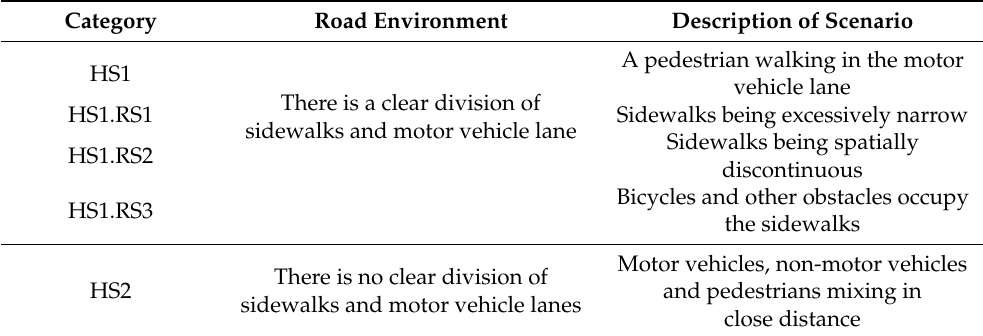
Figure 2. Sidewalks being excessively narrow ( a ), being spatially discontinuous ( b ) and the obstruc- tions occupying the sidewalk ( c ). Table 1. The description of various categories of study scenarios.